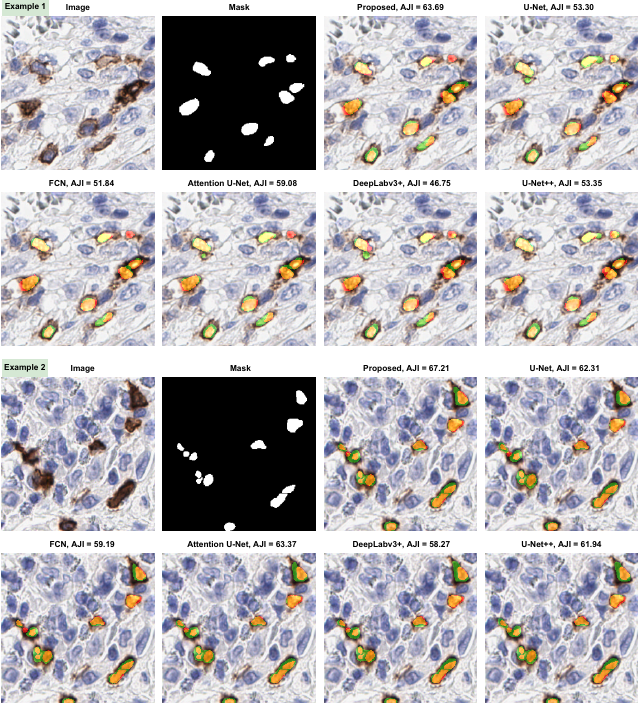
Figure 5. Illustration of proposed model segmentation results compare with five state-of-the-art methods. Color maps shows the following description: orange/yellow (true positive), green (false positive), and red (false